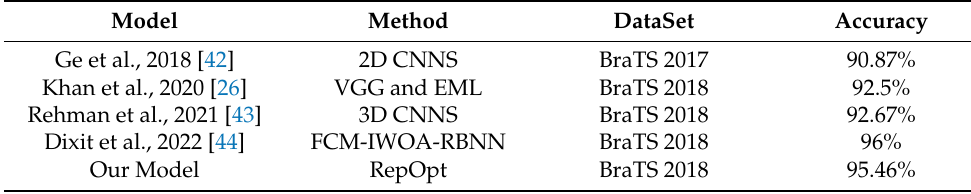
Table 3. Quantitative results of classification model on BraTS